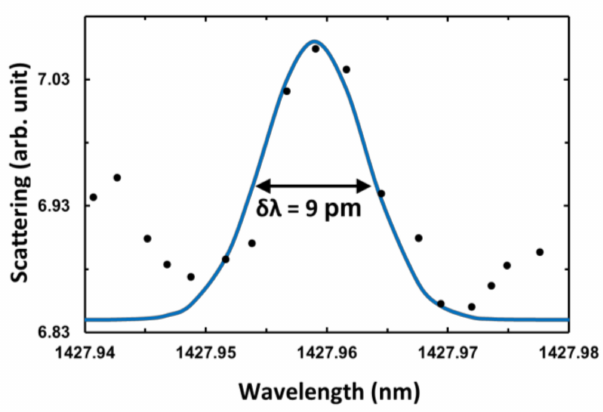
Figure 5. The TM-polarized highest Q-factor 90 ◦ elastic scattering data (black dots) and Lorentzian curve fitting applied to the data (blue